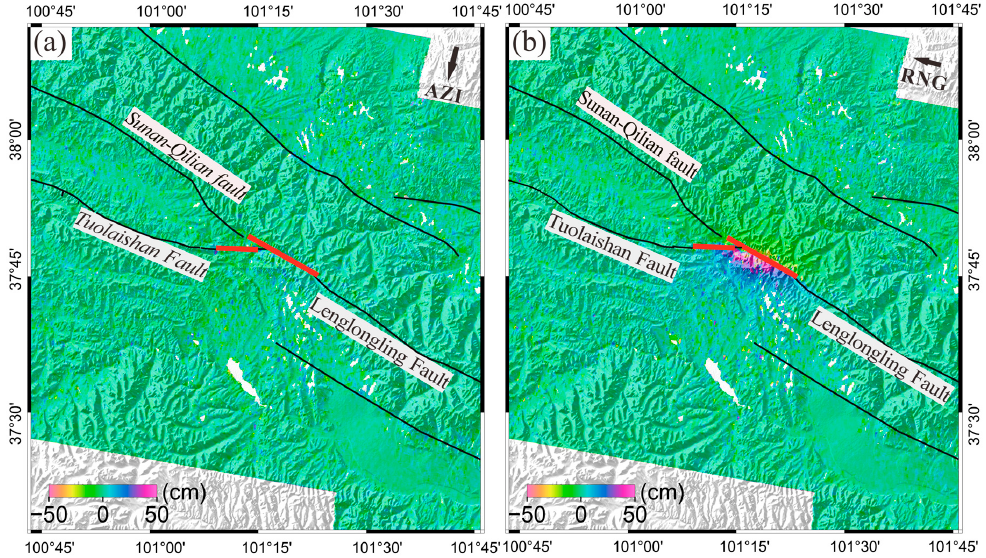
Figure 4. Rupture faults are determined by pixel offset tracking. ( a ) deformation in the azimuth direction and ( b ) deformation in the range direction. The red lines indicate inferred rupture faults.